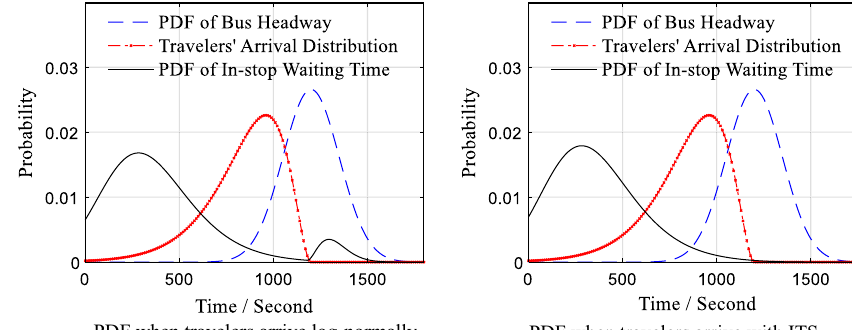
PDF when travelers arrive log-normally PDF when travelers arrive with ITS